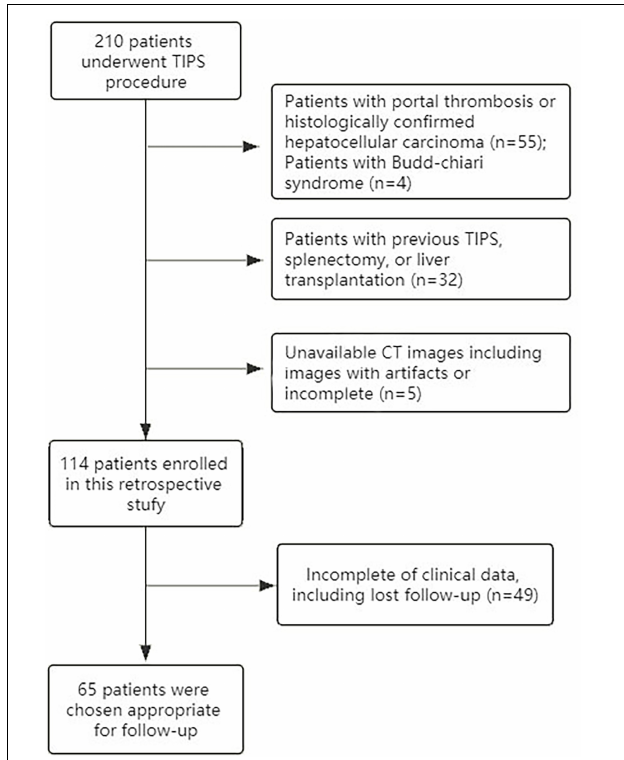
FIGURE 1 | The flowchart of patient